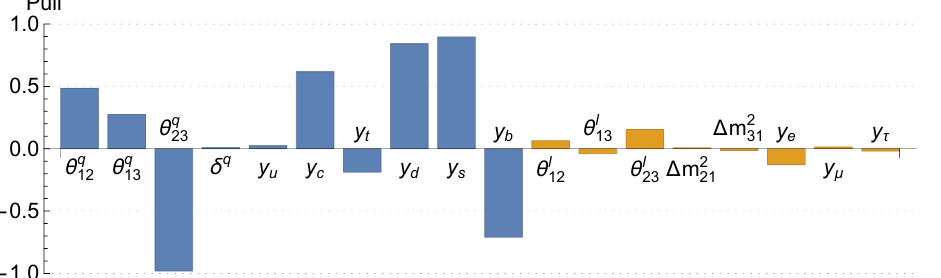
Table 3 . Model predictions in the quark sector for tan (cid:12) = 5, M SUSY = 1 TeV and (cid:22) (cid:17) The observables are at the GUT scale. The quark contribution to the total (cid:31) 2 is 3.38. The model interval is a Bayesian 95% credible interval.